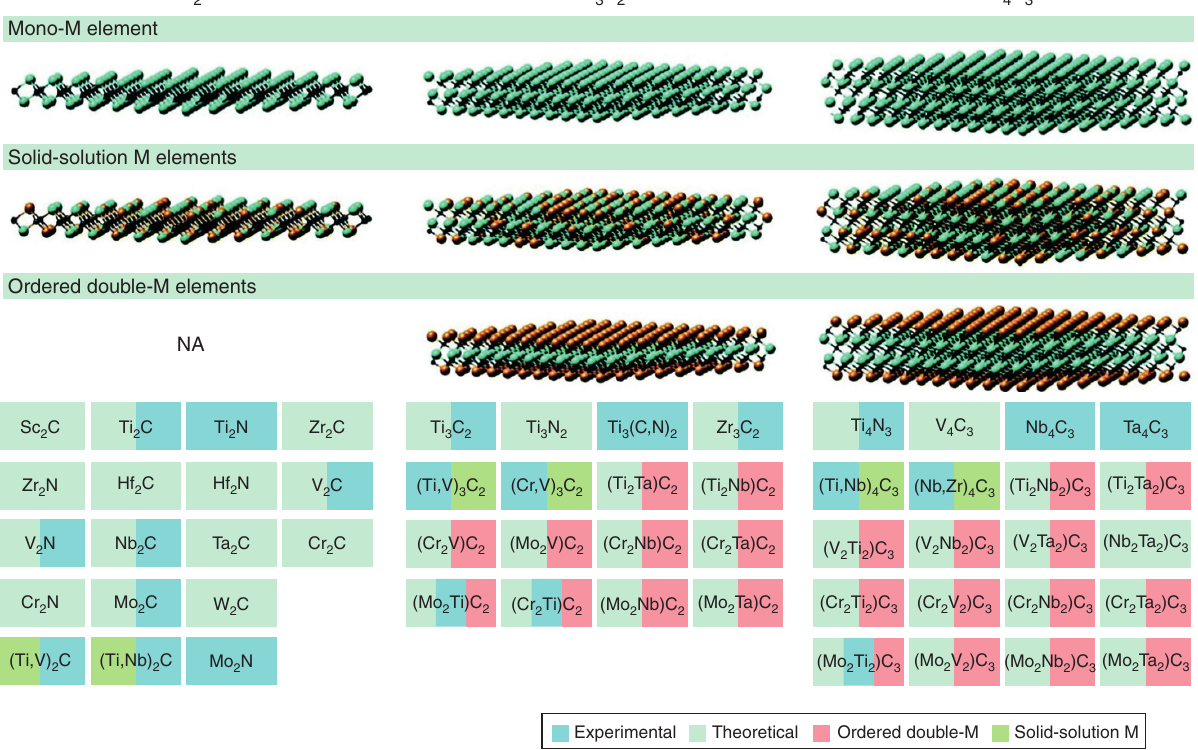
Figure 1: Recently reported MXenes mainly have three kinds of formulas: M X stands for carbon and/or